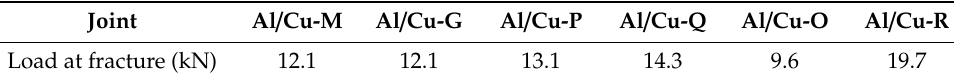
Table 8. The result of the tensile test performed for the joints.